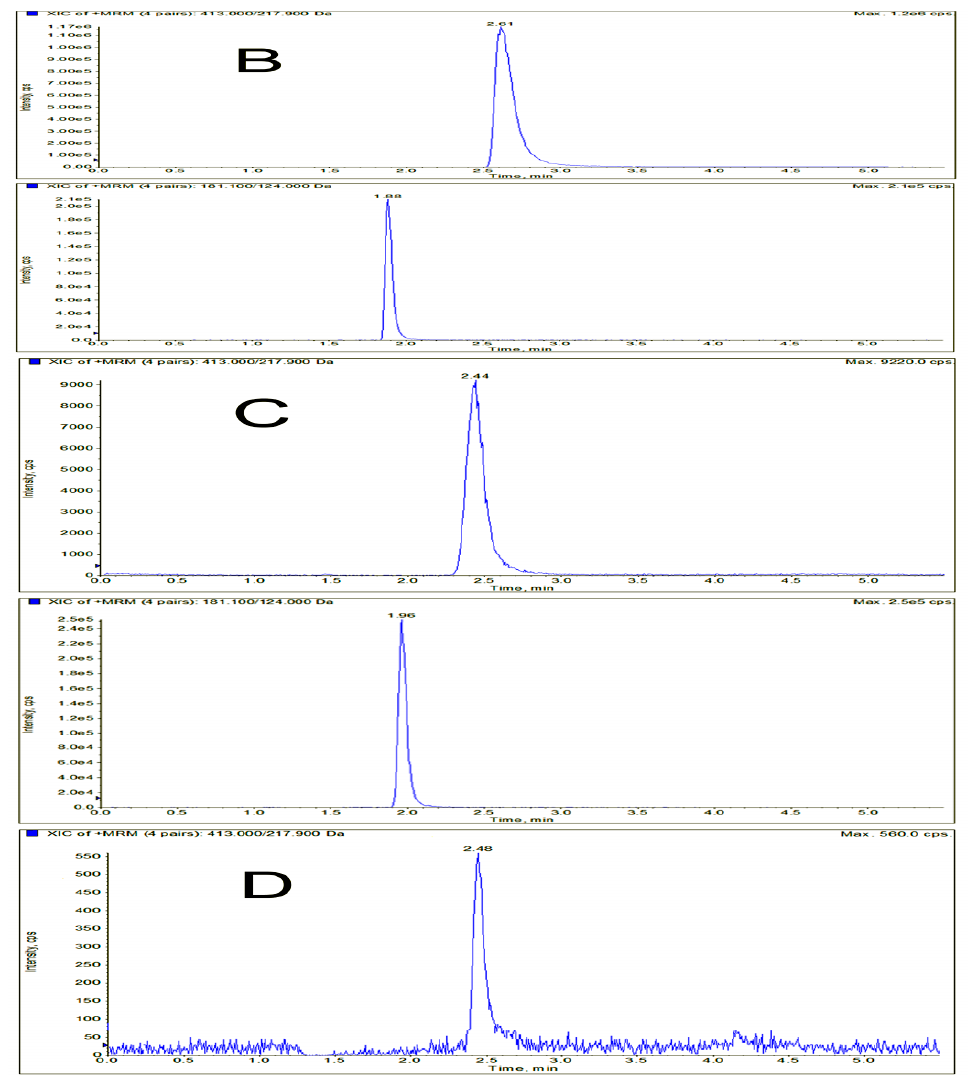
Figure 2. Typical chromatograms of gardneramine and theophylline (I.S.) in rat plasma samples: ( A ) blank rat plasma; ( B ) blank rat plasma spiked with gardneramine (2.61 min) and I.S. (1.88 min); ( C ) plasma sample from the pharmacokinetic study; and ( D ) blank rat plasma spiked with gardneramine at lower limit of quantification